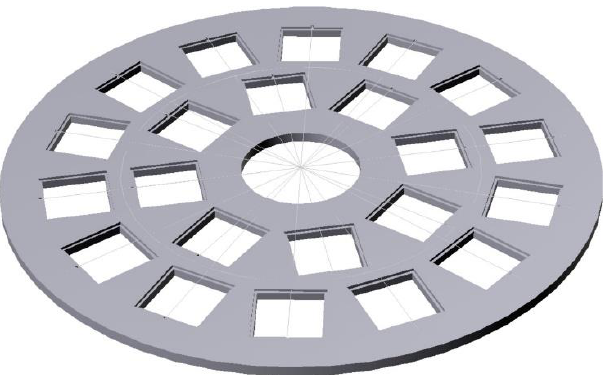
Figure 2. Sketch of the rotating support explicitly constructed for the evaporation of the 6 LiF converters in order to guarantee the uniformity of the deposition.